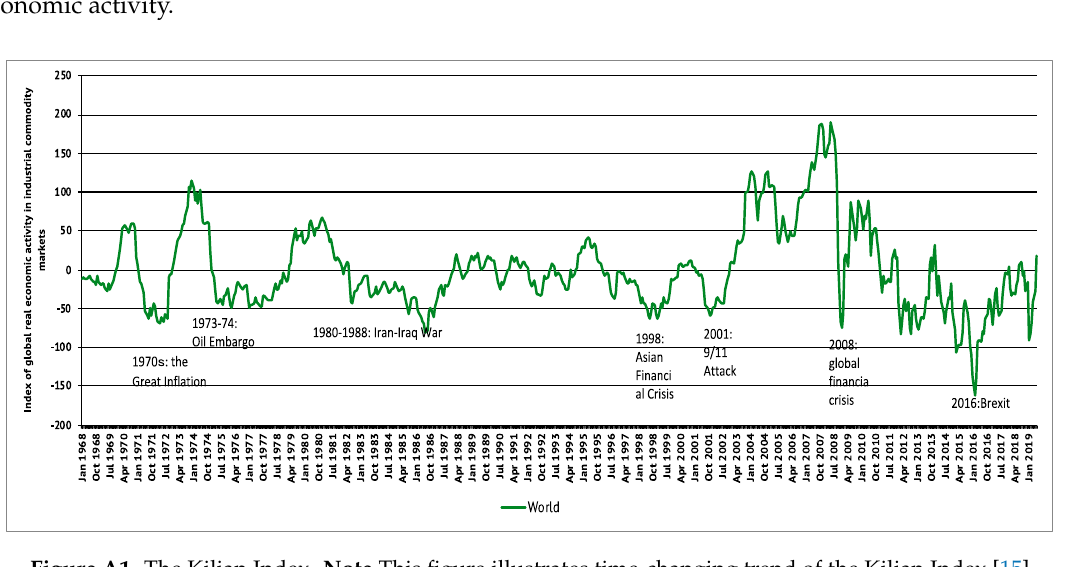
Figure A1. The Kilian Index. Note This figure illustrates time-changing trend of the Kilian Index [15] from Jan. 1968 to Jun. 2019.